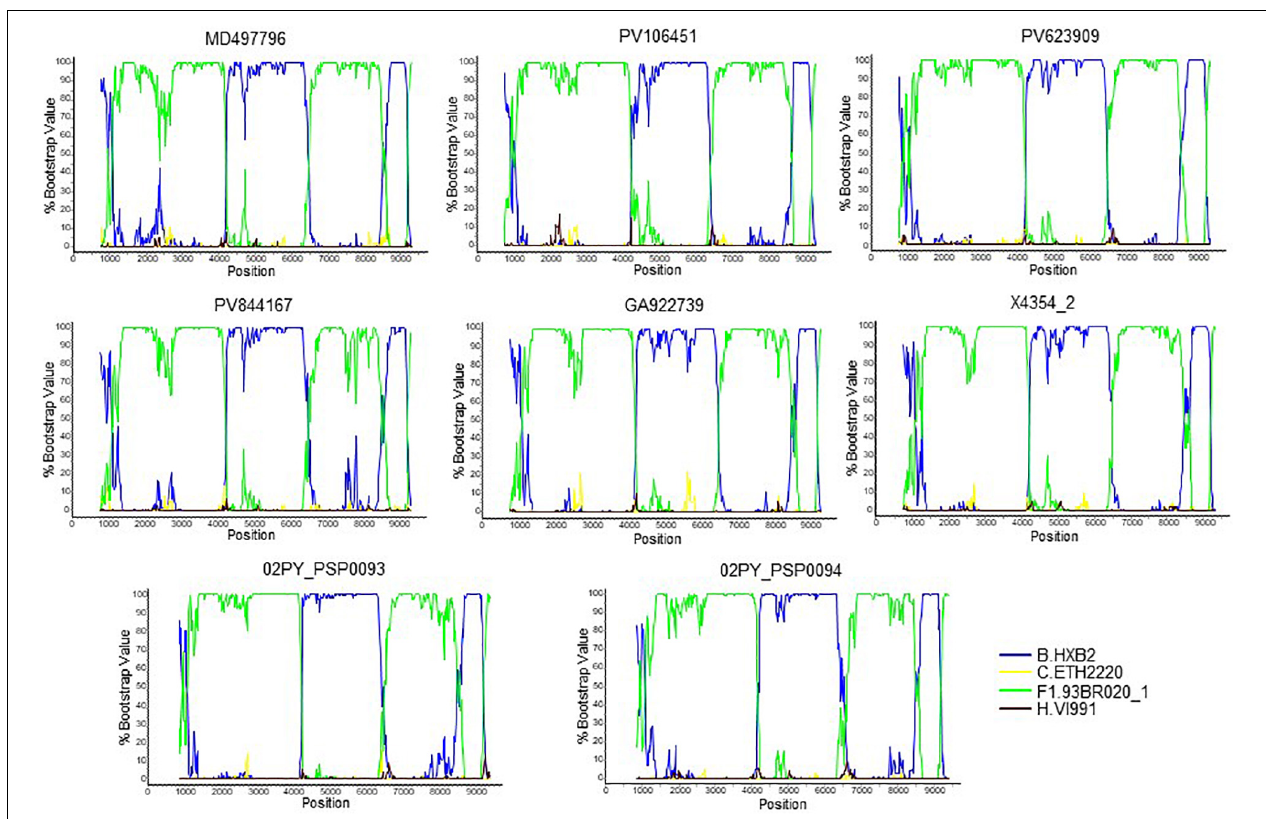
FIGURE 2 | Bootscan analyses of 6 NFLG sequences of viruses of the BF9 cluster obtained by us and of two BF1 database NFLG sequences from Paraguay, 02PY_PSP0093 and 02PY_PSP0094. The horizontal axis represents the position in the HXB2 genome of the midpoint of a 400 nt window moving in 20 nt increments and the vertical axis represents bootstrap values supporting clustering with subtype reference